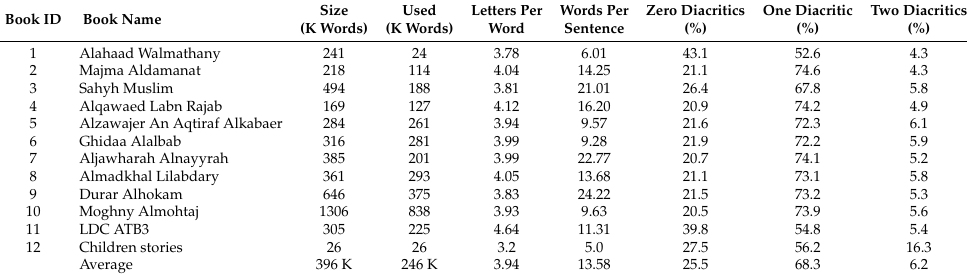
Table 2. Dataset